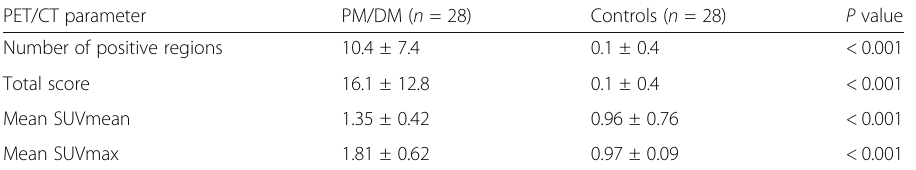
Table 2 18 F-FDG PET/CT findings in patients with PM/DM and in control patients